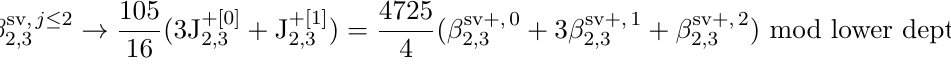
obtained from Poincaré sums over y a E 3 ,k defined in ‘